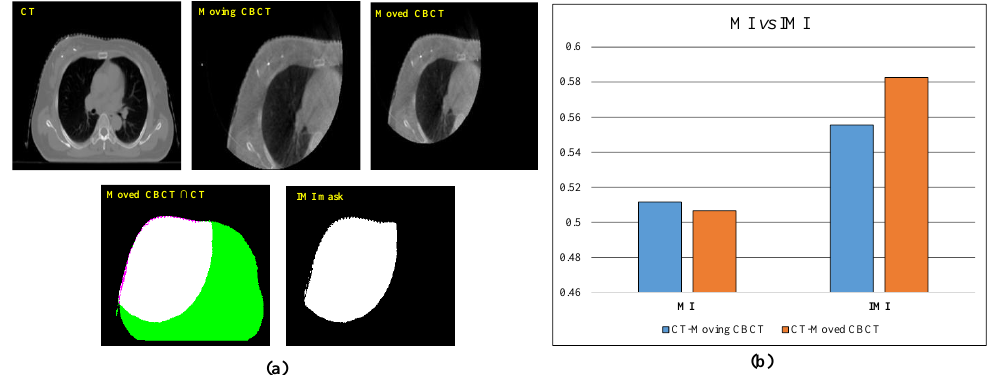
Figure 8. Illustration of IMI. ( a ) The source CT, moving CBCT, moved CBCT, and IMI mask maps. ( b ) The MI and IMI values of CT and moving CBCT and of CT and moved CBCT. The y -axis represents the values of IMI and SSIM metrics.